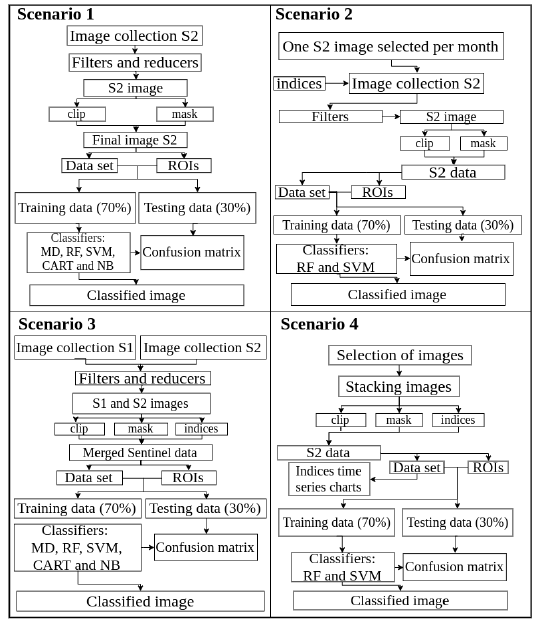
Figure 2. Different scenarios implemented in GEE